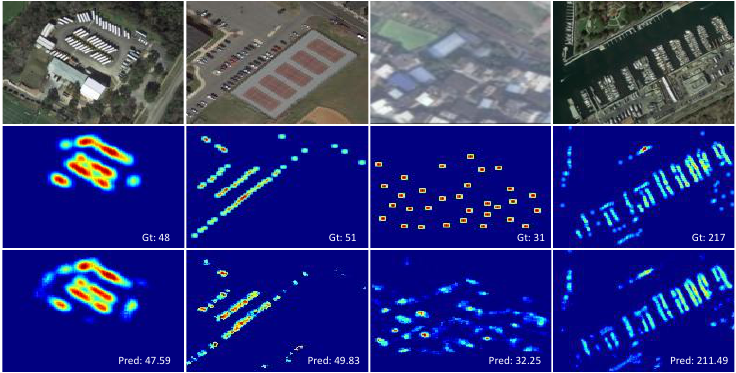
Figure 6. The first row is the input image from four sub-datasets, the second row is the corresponding ground truth, and the last row is the predicted density map of the proposed